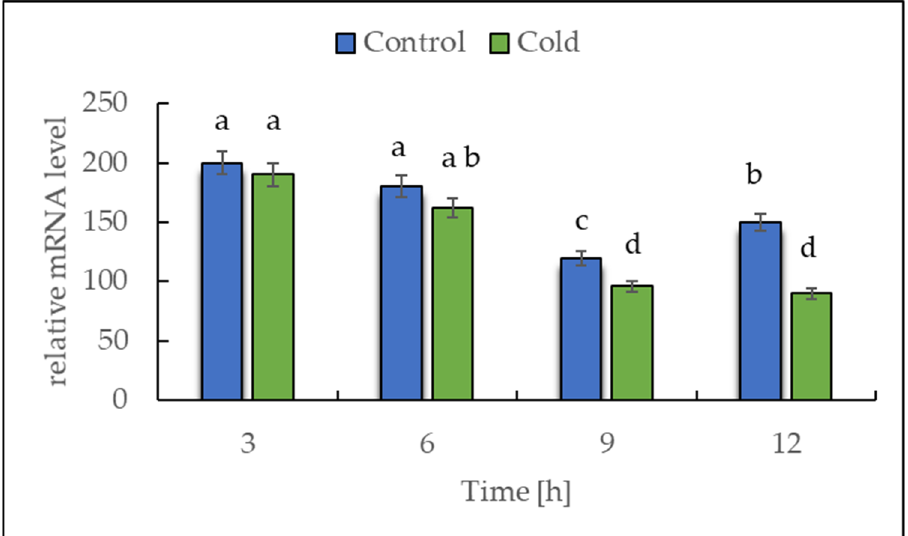
Figure 3. Effect of low temperature on the expression level of NDA1 , homolog of the gene encoding for NADH dehydrogenase. The results are the means of at least three biological replicates ± SD. Different letters at the top of the bars indicate significant differences, which were calculated ( p ≤ 0.05) according to Tukey’s HD post hoc test.